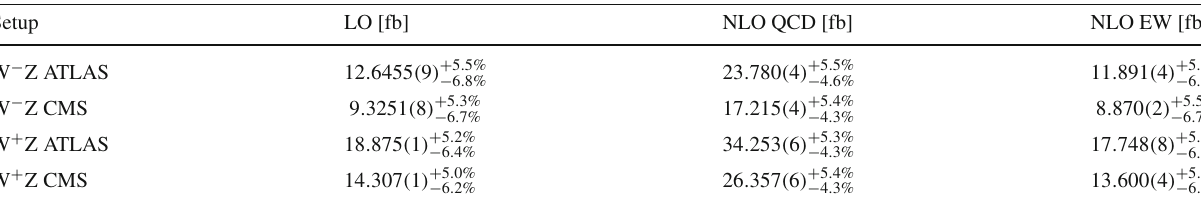
Fig. 9 Ratio between the EFT6 2 contribution to the process pp → e + ν e μ − ¯ ν μ computed at NLO QCD ( σ NLO ) EFT6 2 and LO ( σ LO ) accuracy as a EFT6 2 function of the hardest lepton p T (left plot) and as a function of the charged-lepton-pair invariant mass. The labels ATLAS and CMS refer to the event selections of Eq. (4.4) and (4.5), respectively. The ratio between the SM predictions at . NLO QCD and at LO accuracy is also shown (black lines)